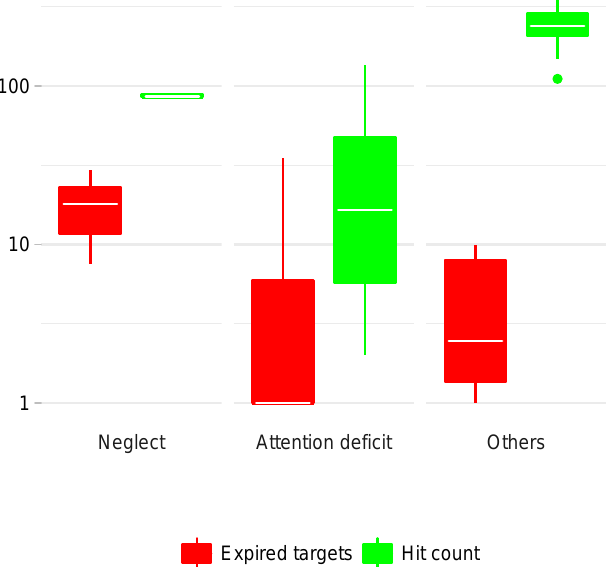
Figure 4. Distribution of participants’ median hit counts and expired targets by group (N=23)